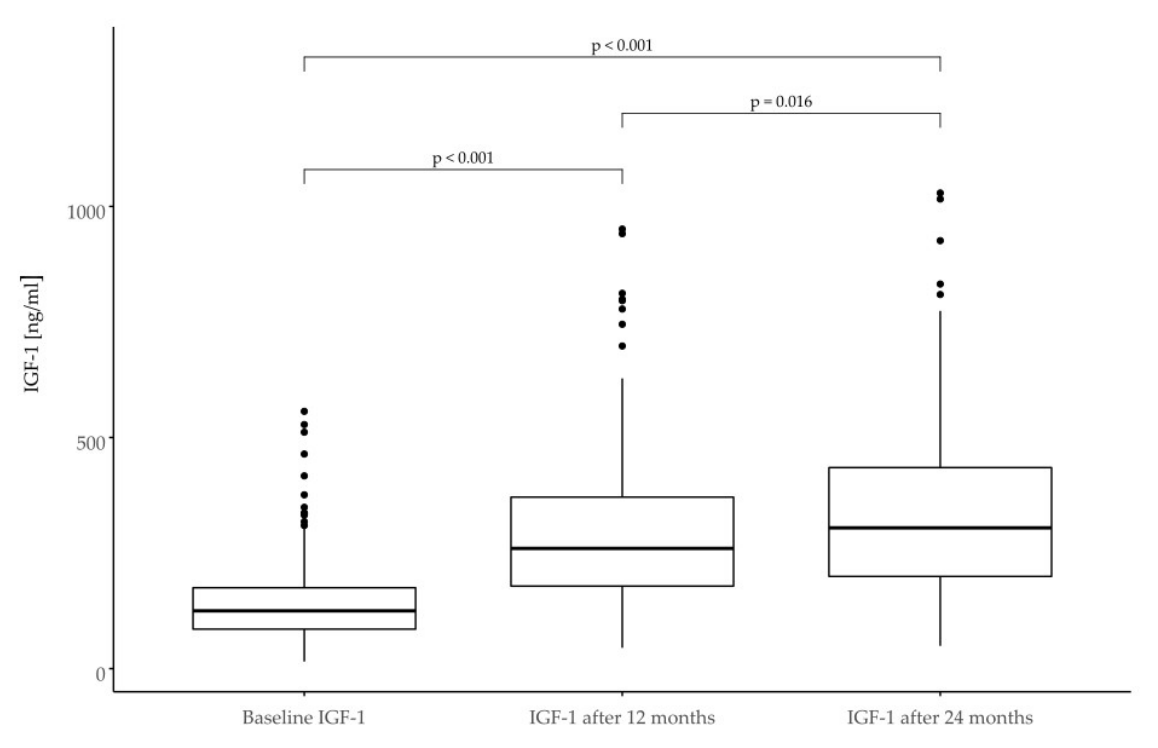
Figure 4. IGF-1 serum concentration values expressed in ng/mL at the baseline and after 12 and 24 months of treatment.